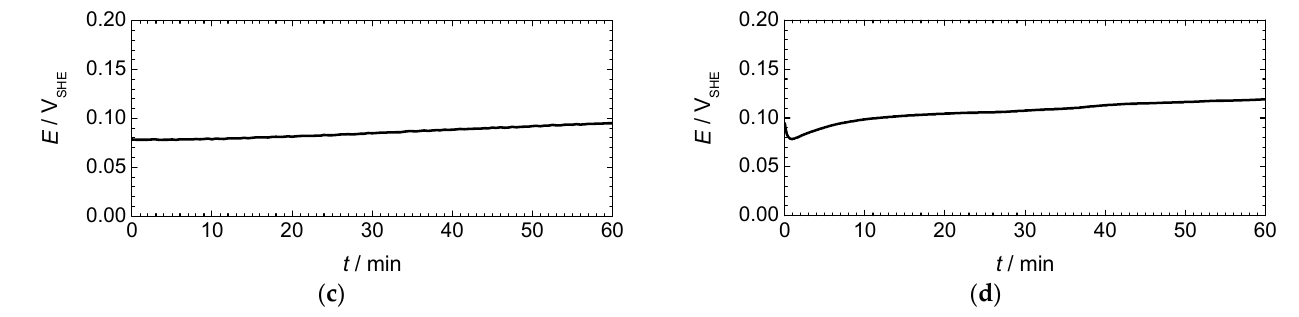
Figure 1. Potentiodynamic polarization curves and open circuit potential measurement in 0.1 M Na 2 SO 4 + 0.1 ppm F − 1 (pH = 5): ( a , c ) AISI 442 steel sample; ( b , d ) AISI 446 steel sample. Scan rate 1